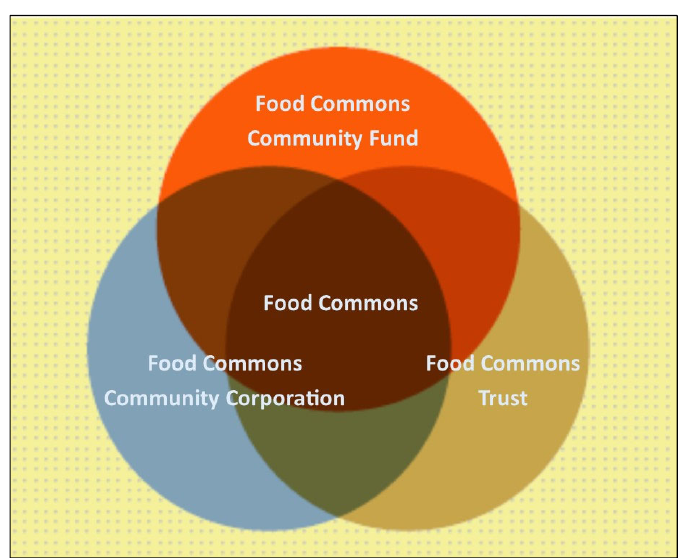
Figure 1. Food Commons